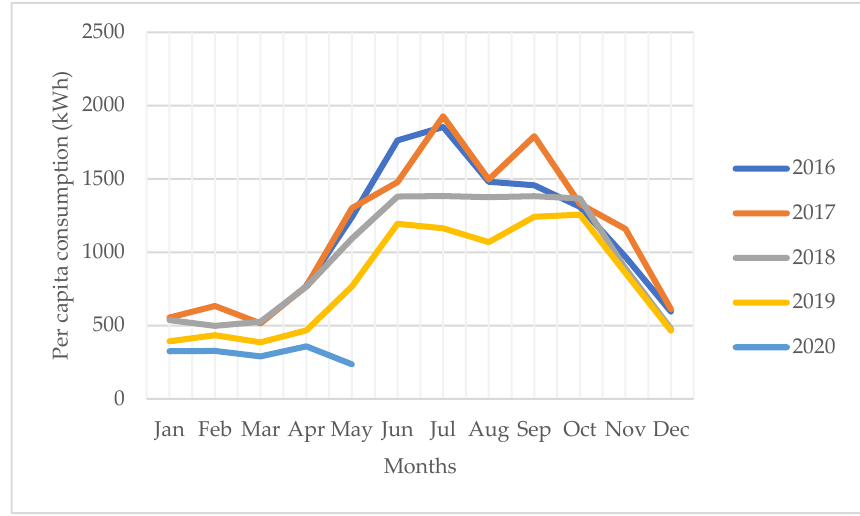
Figure 3. Electricity consumption trend: 2016 – 2020. Table 6. Attributes of the